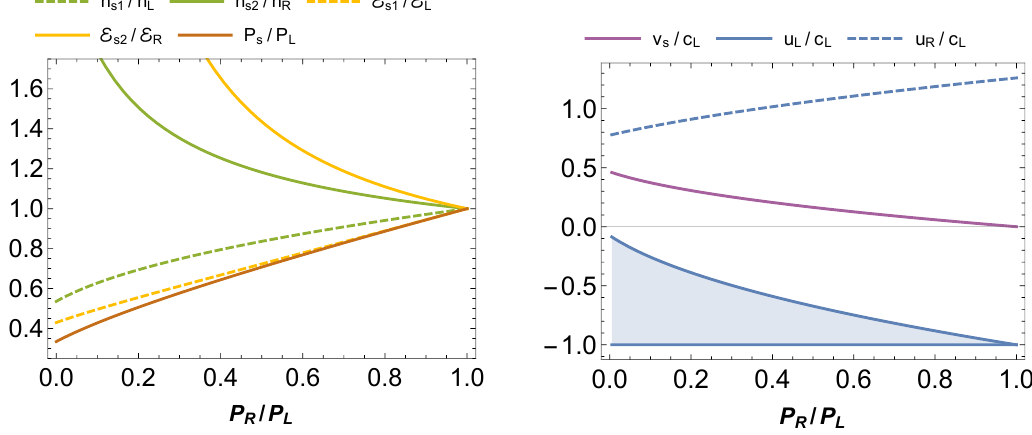
Figure 6. NESS variables for z = 3, d = 3 as a function of P R =P L for (cid:12)xed n L =n R = 2.